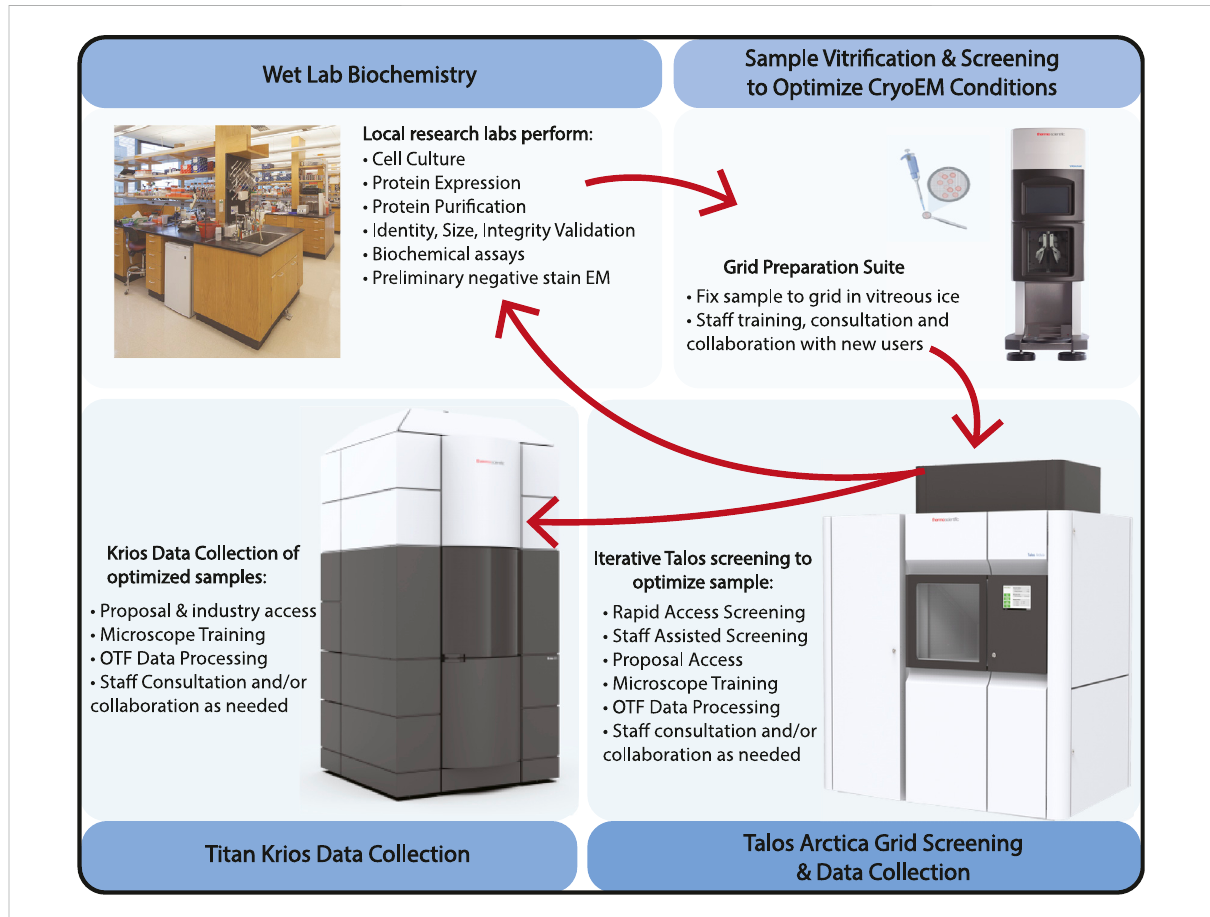
FIGURE 3 Sample Optimization Flowchart. The cryo-EM sample optimization process at HC 2 EM starts with biochemical identi fi cation and evaluation in neighboring wet labs, iterative grid freezing and image screening on the Talos Arctica to re fi ne and optimize cryo conditions, and fi nal high- resolutiondatacollectiononeithertheTalosArcticaorTitanKrios.Foracademicusers,theTalosmicroscopecanbeusedforgeneraldatacollection but also has to become simply proposal-free screening routes that allow users to generate data required to submit a Titan Krios proposal. Vitrobot, Talos Arctica,andTitan Krios areproducts ofThermo FisherScienti fi c, Inc.The pipette andgrid imagewerecreated